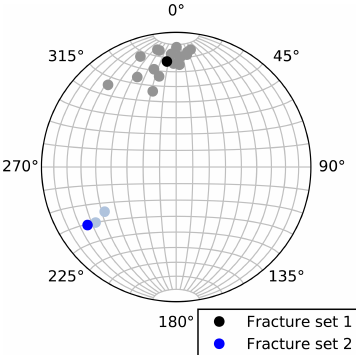
Figure 4. Orientations of the structures between the fault cores of the S3 shear zones in the injection boreholes observed from optical televiewer logs (Krietsch et al., 2018), shown in gray and light blue, as well as the calculated orientations for the fracture sets applied for the conceptual model.